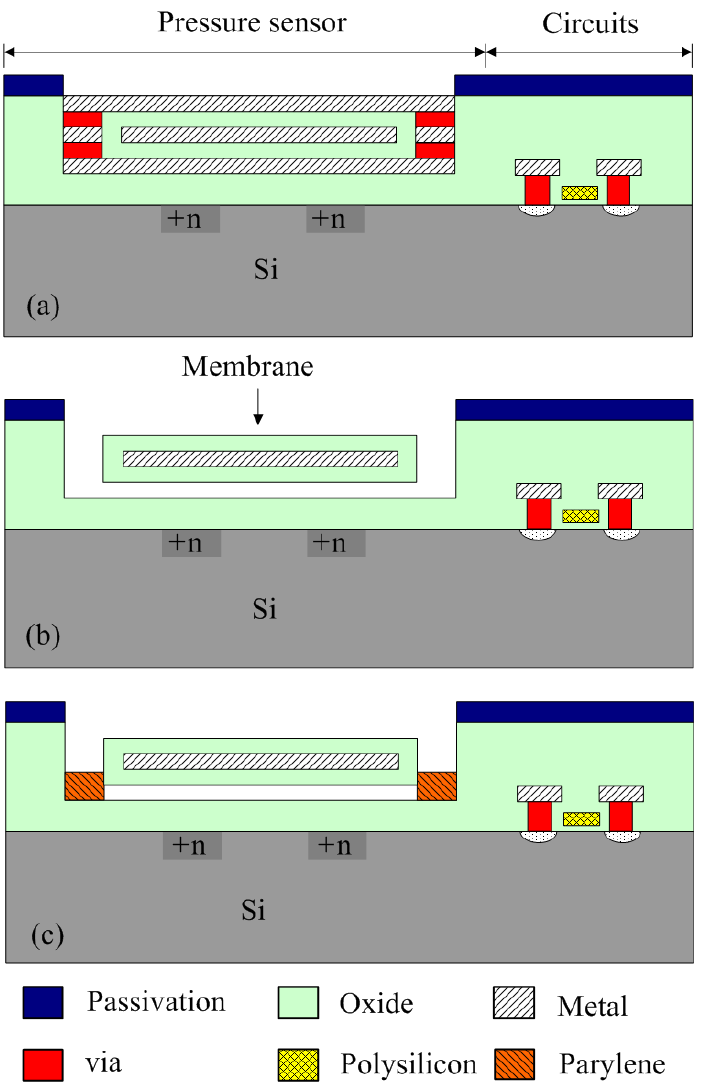
Figure 9. Process flow of the wireless pressure sensor: (a) after completion of CMOS process, (b) etching the sacrificial layers, and (c) sealing the etch